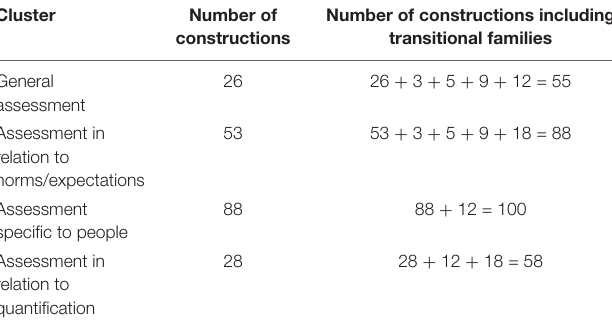
TABLE 2 | Distributions of Assessment constructions across the four